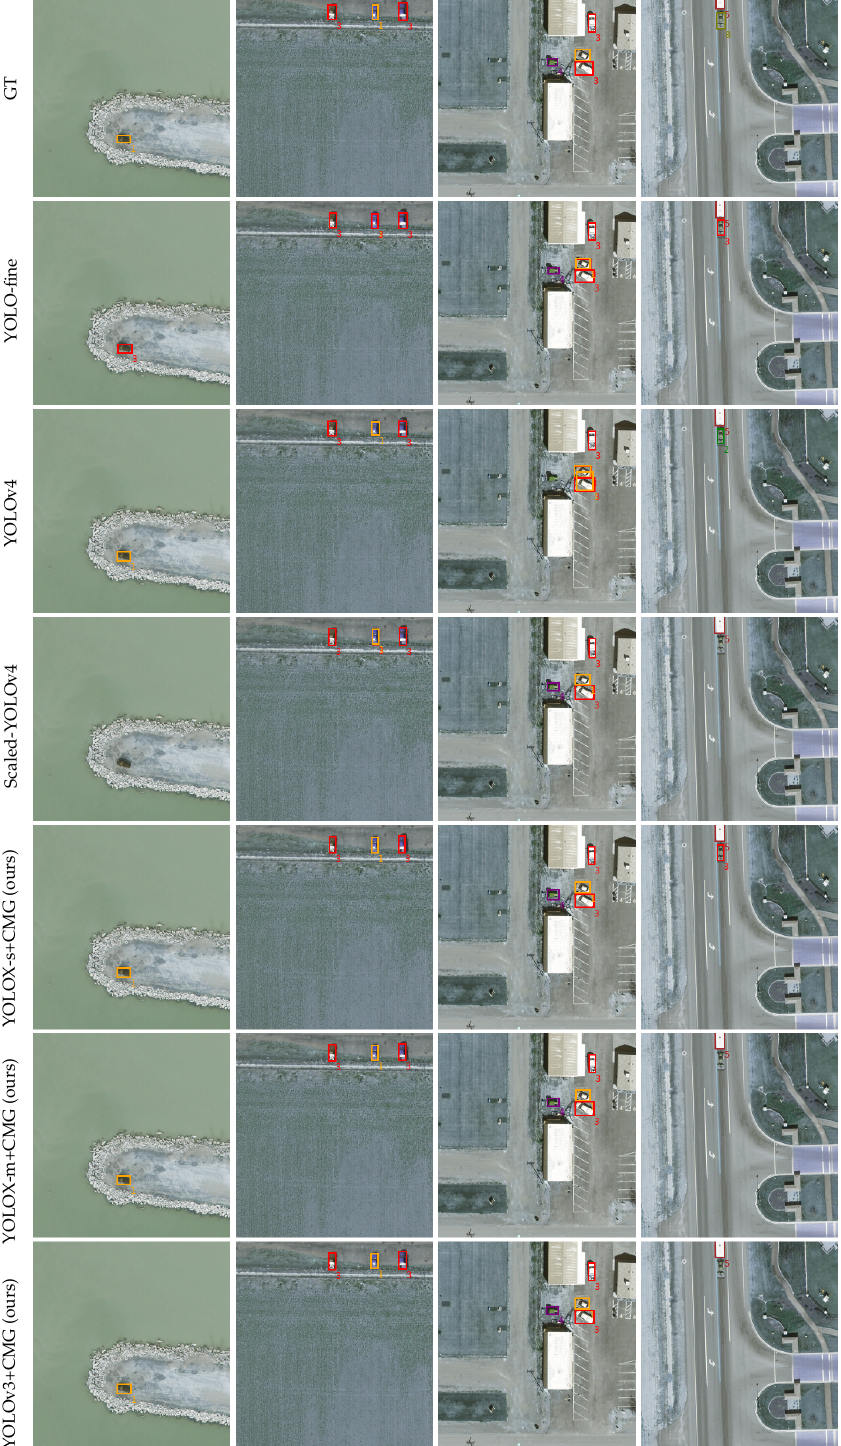
Figure 7. Qualitative results of our methods and state-of-the-art methods on VEDAI25. The number and color of each box correspond to one of the classes, i.e. (1) car, (2) truck, (3) pickup, (4) tractor, (5) camper, (6) ship, (7) van, and (8) plane. The last column shows a failure case. Our method has difficulties in recognizing the “other” class, which comprises various object